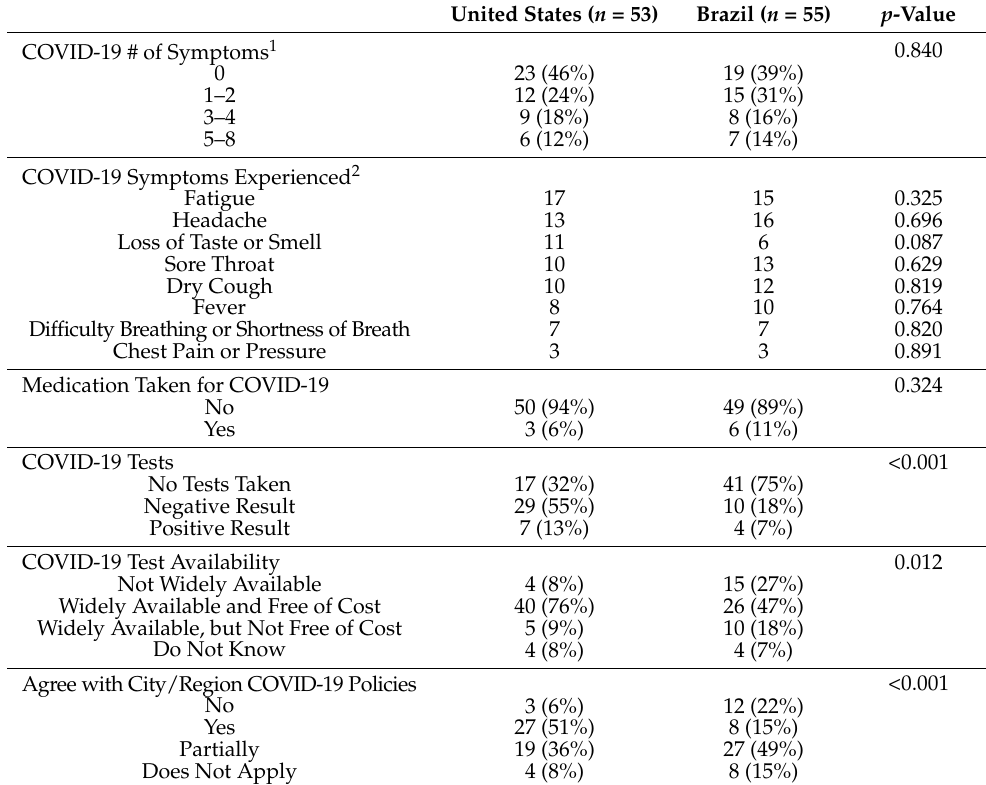
Table 2. Student perceptions and experiences around COVID-19 physical characteristics and